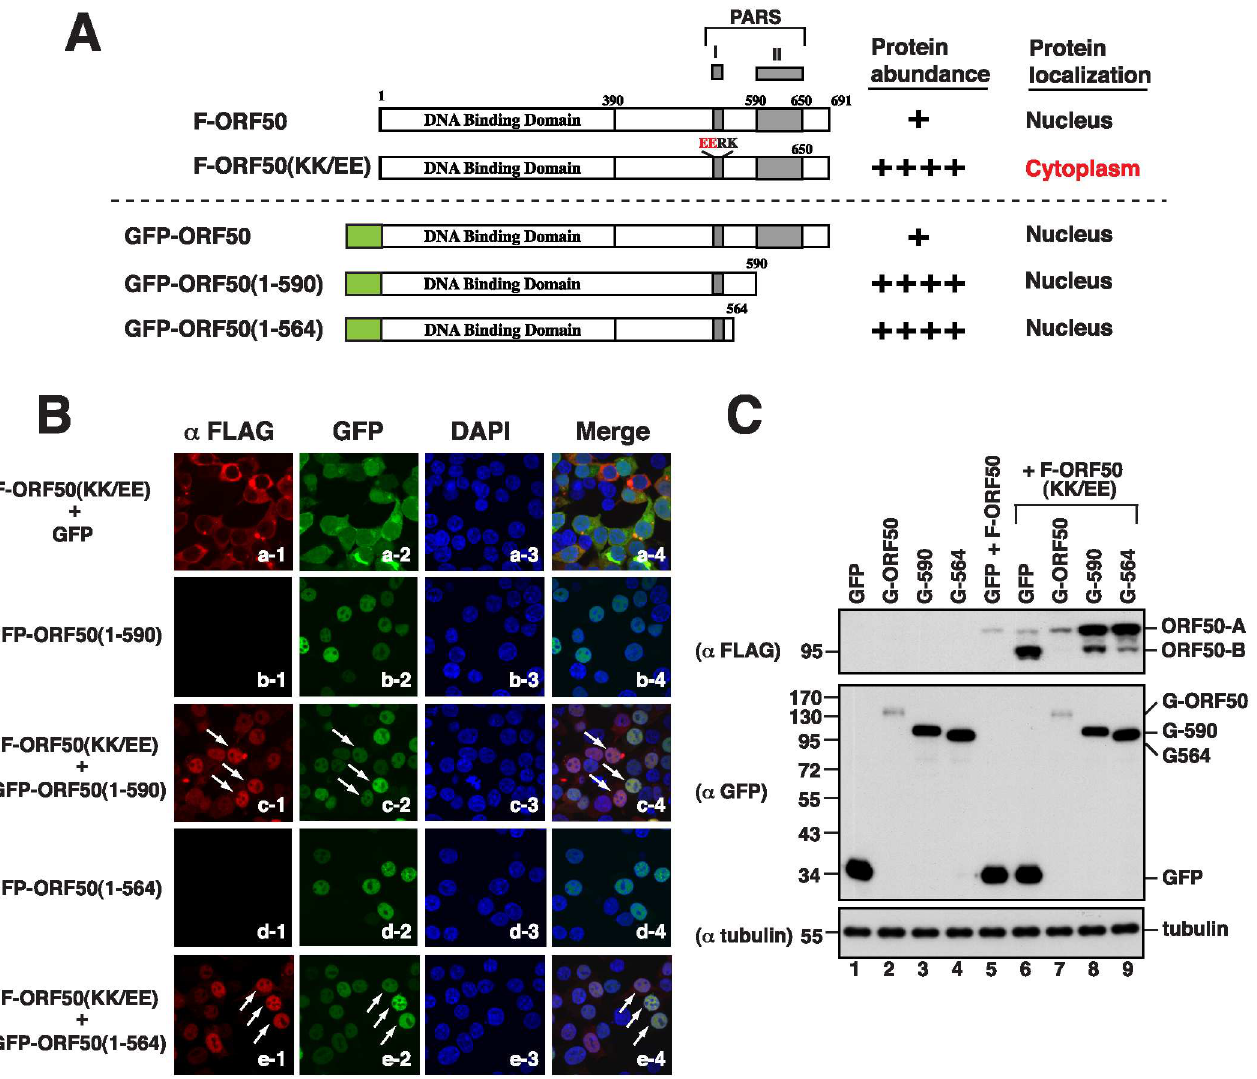
Fig 5. Phenotypic changes of F-ORF50(KK/EE) by different GFP-ORF50 deletion effectors. (A) Diagram of GFP-ORF50 deletion constructs and a summary of their characteristics. (B) Confocal images of 293T cells coexpressing F-ORF50(KK/EE) and GFP-ORF50 mutants. The subcellular localizationof both F-ORF50(KK/EE) (red) and GFP-tagged proteins (green) in transfected cells was analyzedby confocal microscopy. (C) Effect of GFP-ORF50 deletion mutants on the expression of F-ORF50(KK/EE). 293T cells were cotranfected with equal amounts (400 ng) of plasmids encoding F-ORF50(KK/EE) and the indicatedGFP-tagged proteins. Cell lysates were immunoblotted with either anti-FLAG antibody or anti-GFP